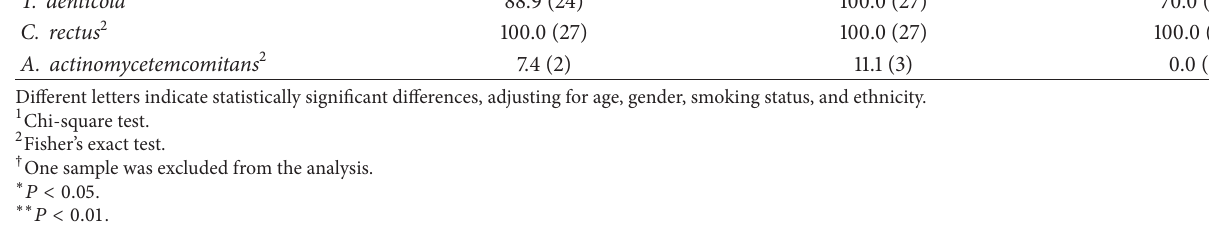
Table 3: Concentrations (pg/mL) of the detected inflammatory molecules by ELISA ( 𝑛 = 80